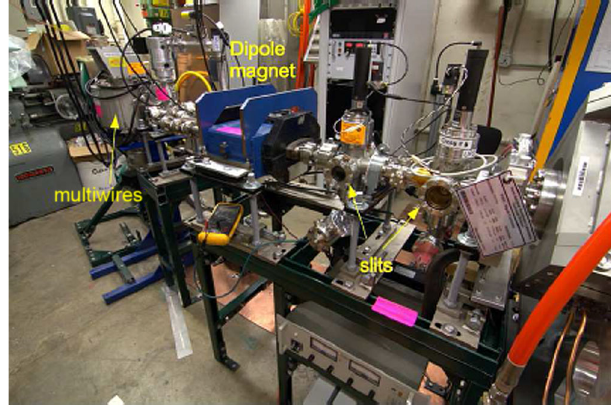
FIG. 11. A view of the ES setup for the energy measurement. The two slits downstream of the RFQ define the longitudinal axis. The deflected beam is measured on the multiwires which is 981.8 mm downstream from the center of the